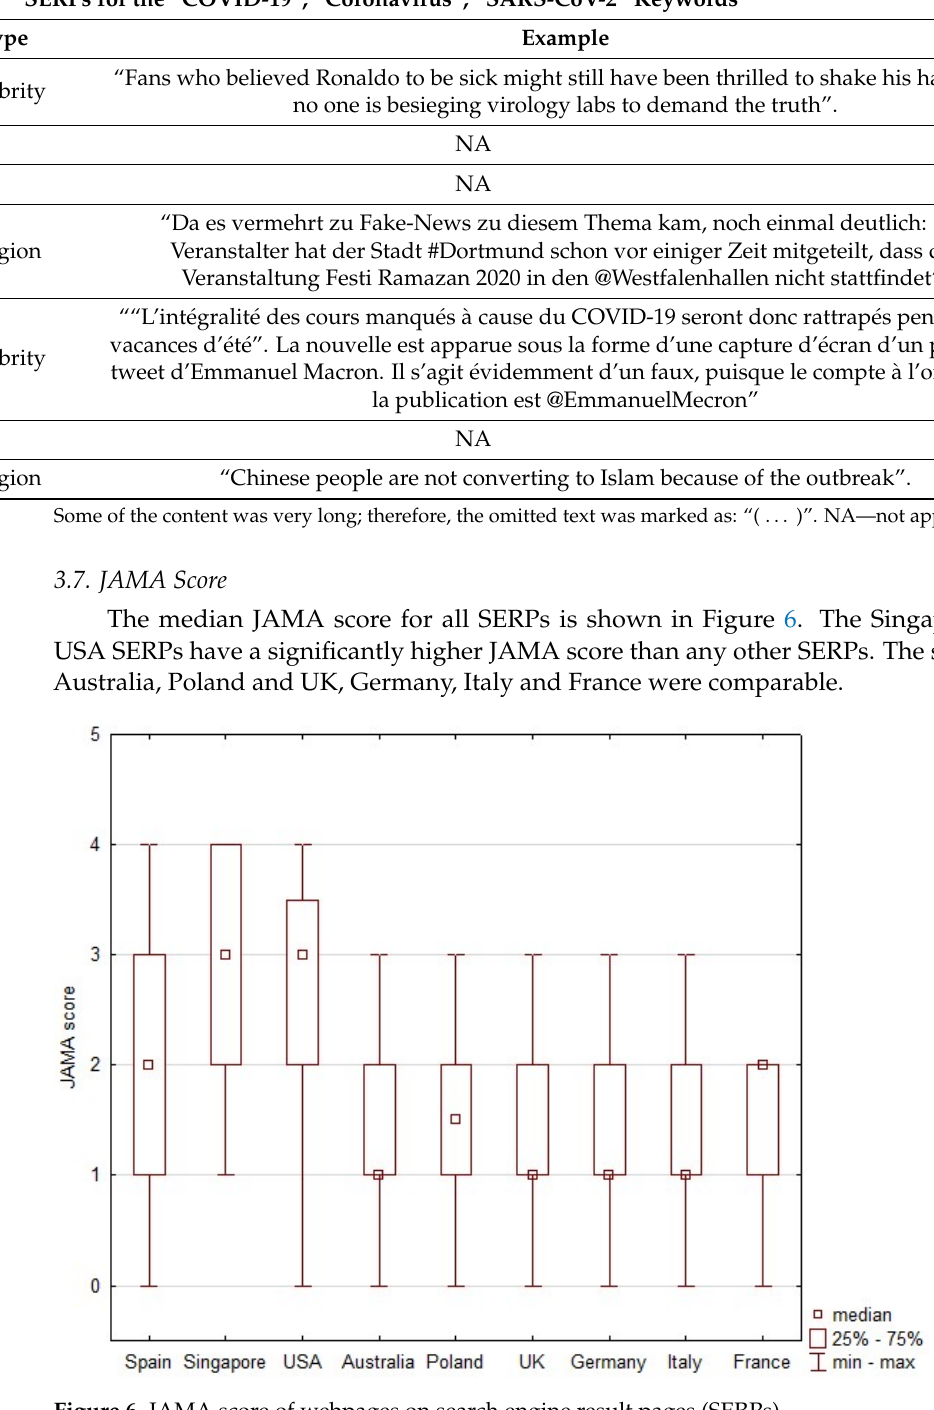
Figure 6. JAMA score of webpages on search engine result pages